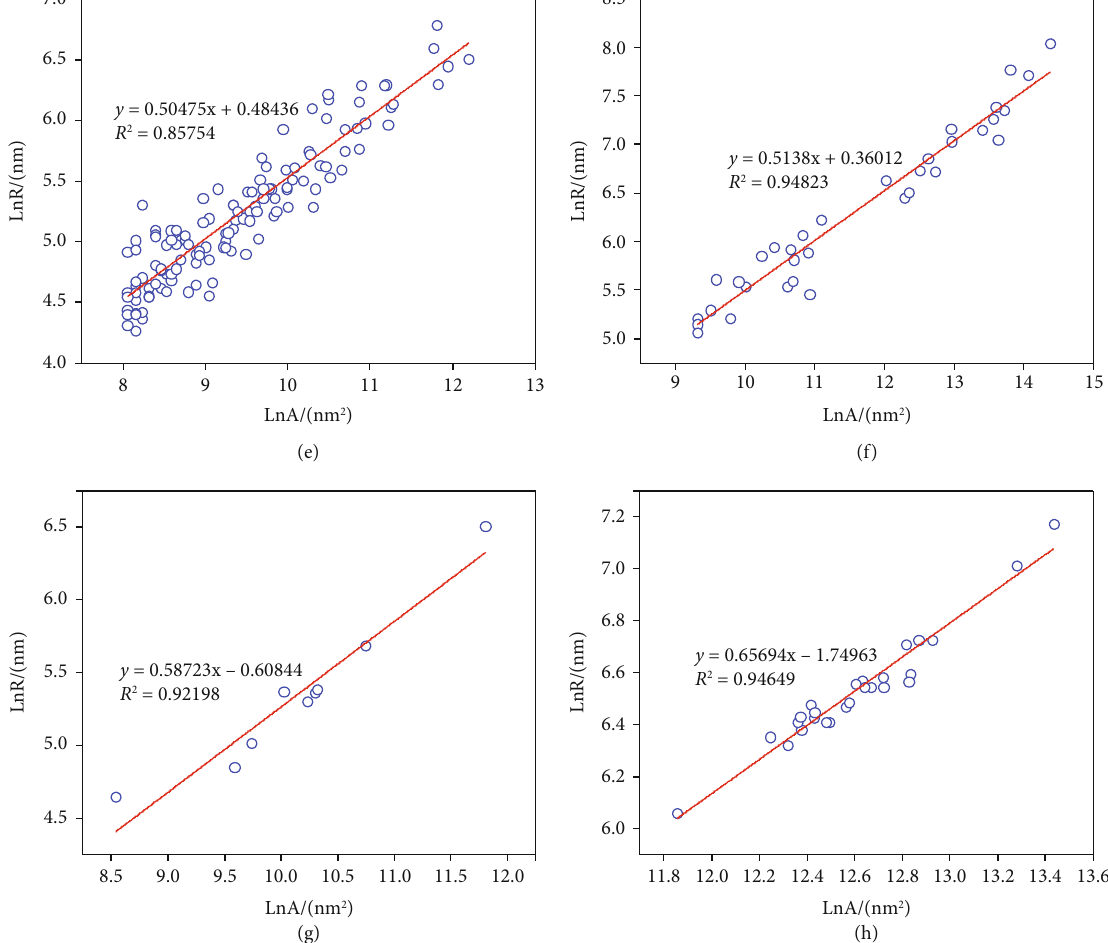
Figure 5: Double logarithmic curves of pore long axis and area in SEM images of shale with di ff erent pore types in well